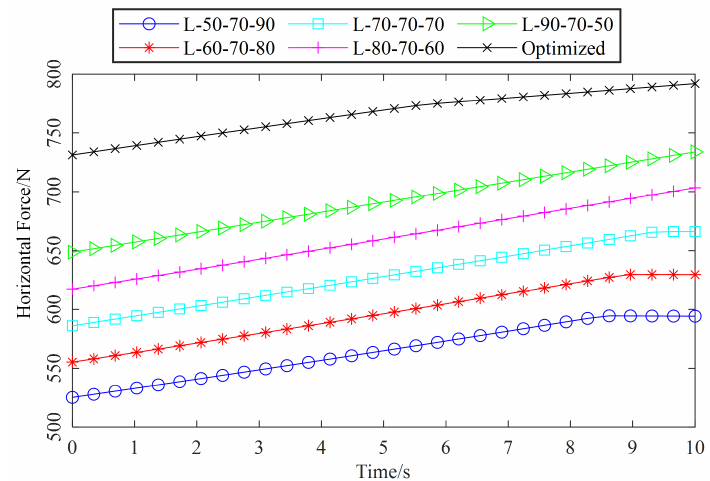
Figure 7. Comparison of the maximum reachable horizontal forces obtained by different distributions of the unit lengths along the same given trajectory. (‘L’ denotes ‘length’, and the numbers after L represent the initial lengths of each unit. For example, ‘L-50-70-90’ represents that the initial length of the 1st, 2nd, and 3rd units are respectively 50, 70, and 90